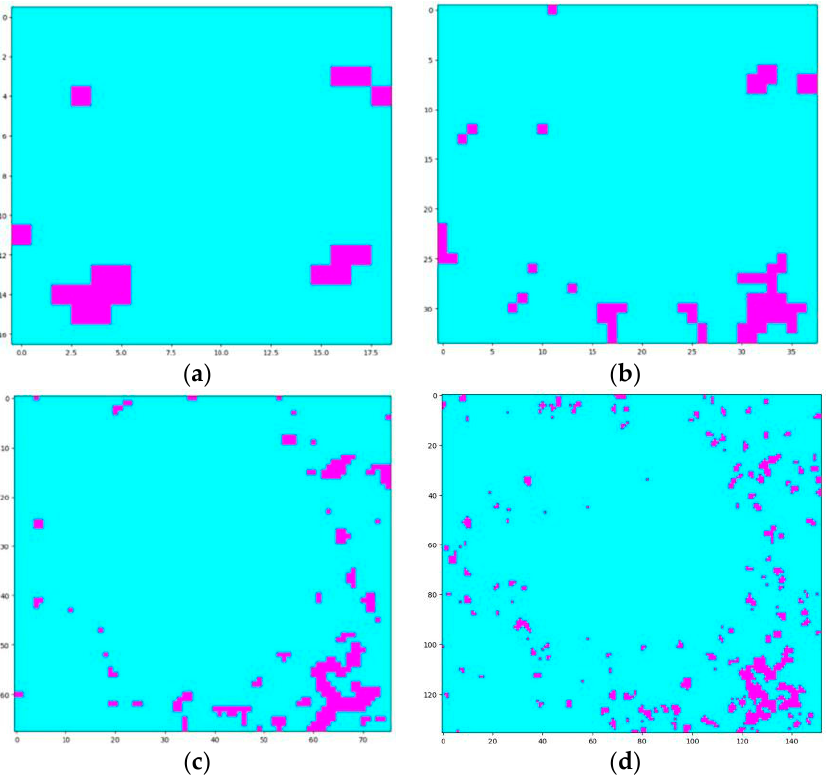
Figure 12. Q1 query results by RALL for the different sizes of the grids. ( a ) The 4 km 2 size of the grid. ( b ) The 1 km 2 size of the grid. ( c ) The 0.25 km 2 size of the grid. ( d ) The 0.0625 km 2 size of the grid. With the same query area ratio set for different tasks, the corresponding F-values were: (a) 0.141, (b) 0.339, (c) 0.297, and (d) 0.215.